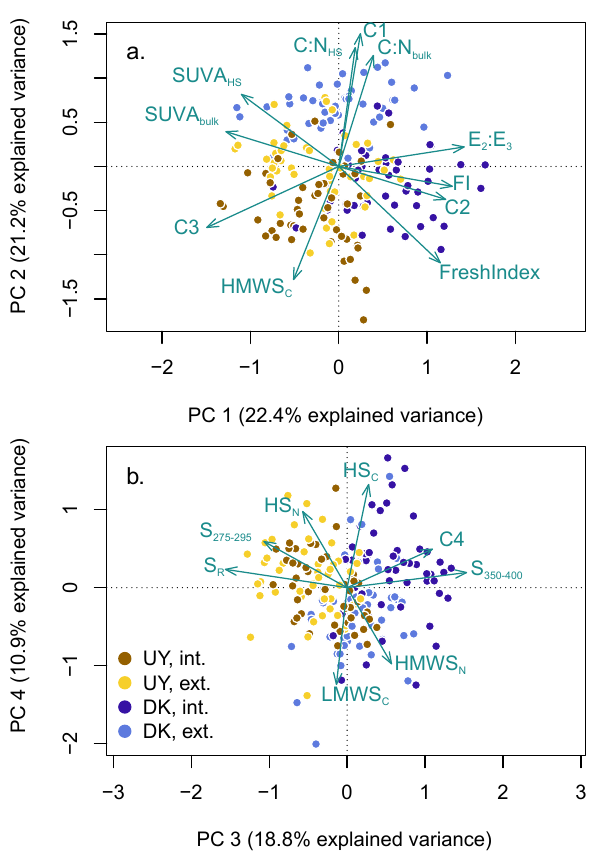
Figure 3. Principal component analysis (PCA) of dissolved or- ganic matter (DOM) composition. The first four axes – PCA axis 1 and 2: (a) , PCA axis 3 and 4: (b) – of the PCA explain 73% of the variance. Only those DOM composition variables are shown which can be interpreted with high confidence (Borcard et al., 2011). C 1– C 4: fluorescence components 1 to 4 based on parallel factor anal- ysis (see also Table 3); FI, fluorescence index; FreshIndex, fresh- ness index; E 2 : E 3 , ratio of absorbance at 250nm to absorbance at 365nm; S 275 − 295 , S 350 − 400 and S R , slope of absorbance at 275–285nm, 350–400nm and the ratio ( R ) of these two slopes; SUVA HS and SUVA bulk , absorbance at 254nm, normalized by dis- solved organic carbon concentration, for humic substances (HS) and all DOM fractions, respectively; C:N HS and C:N bulk , mo- lar carbon to nitrogen ratio for HS and all DOM fractions, re- spectively; HS C and HS N , HMWS C and HMWS N or LMWS C , carbon (C) and nitrogen (N) in the humic substance (HS), high- molecular weight substance (HMWS) or low-molecular weight sub- stance fraction (LMWS) based on size-exclusion chromatography. No values for LMWS N exist, because N in LMWS is indistinguish- able from N in nitrate. DK, Denmark; UY, Uruguay; extensive, ex- tensive farming; intensive, intensive